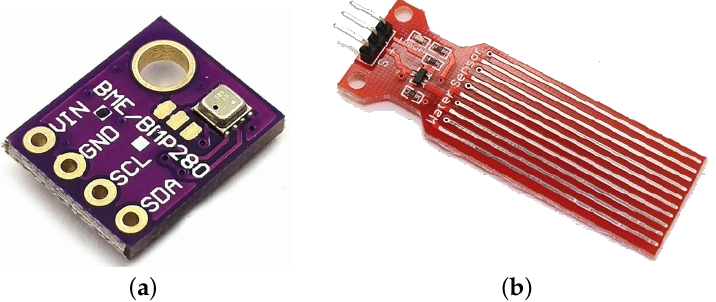
Figure 10. The two sensors used for the sensor node application. ( a ) Digital temperature sensor. ( b ) Analog water level